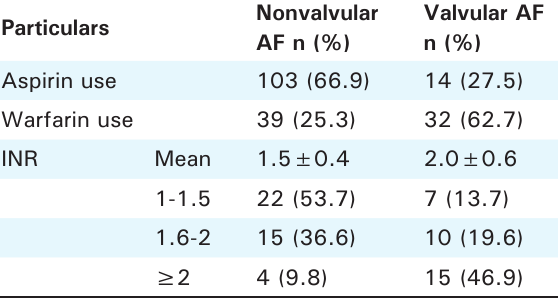
Table 5. Use of warfarin in atrial